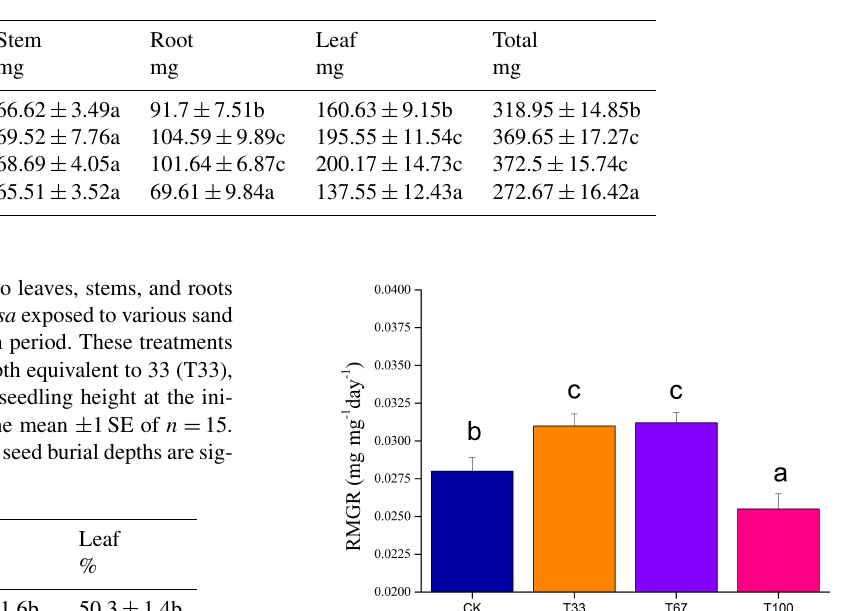
Table 1. Dry biomass of leaves, stems, and roots for seedlings of Ulmus pumila var. sabulosa exposed to various sand burial treatments during a 45-day growth period. These treatments included sand burial of seedlings to a depth equivalent to 33 (T33), 67 (T67), or 100% (T100) of the mean seedling height at the initiation of the study. Each histogram is the mean ± 1SE of n = 15. Different letters in a row among seed burial depths are significantly different at P <0.05.